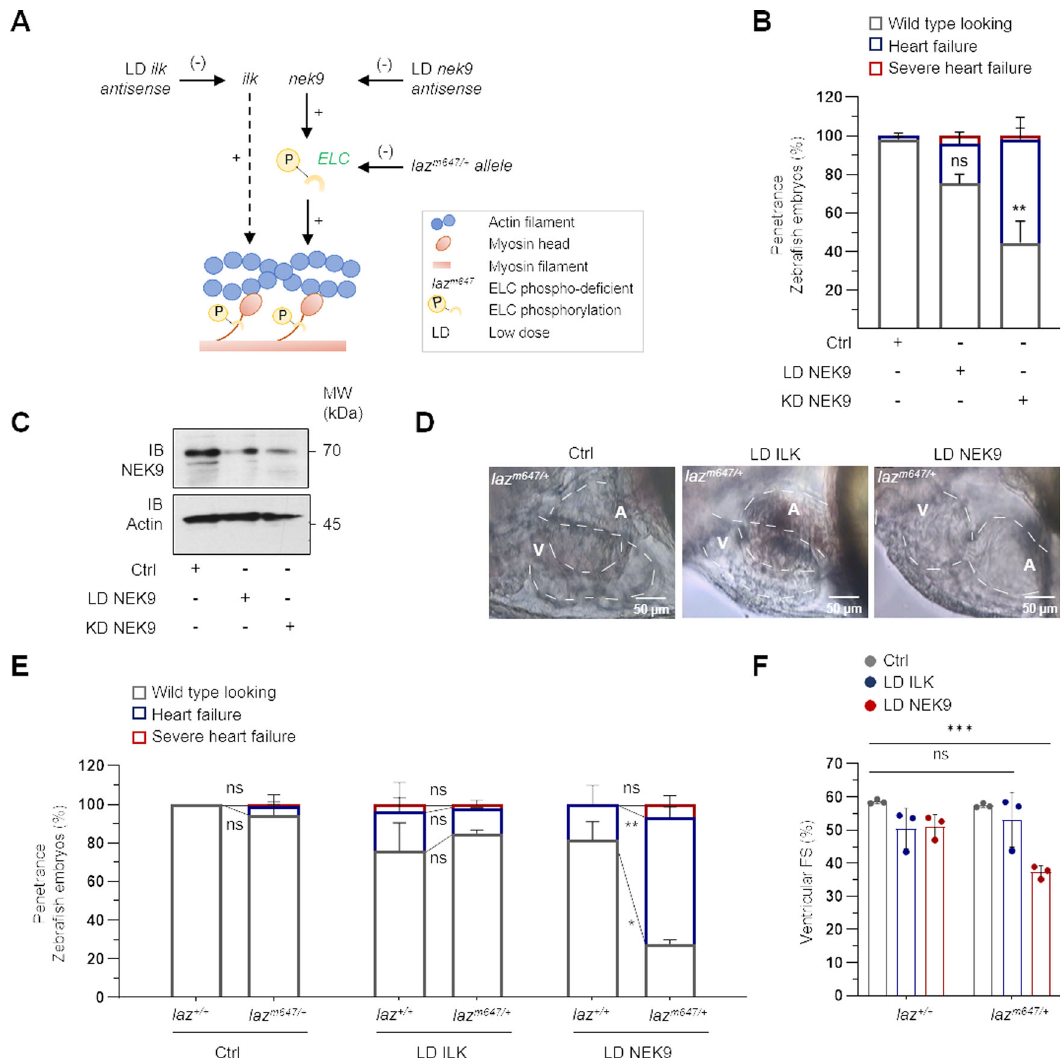
Fig.6|FunctionalcouplingofELCandNEK9in-vivo.A Schematicillustrationof geneticsensitizingby nek9 in anELC phospho-de fi cient geneticbackground.The concept is based on the progressive ampli fi cation of a response by functionally coupled factors. B Penetrance of NEK9 KD in zebra fi sh embryos at 72 hpf. Dif- ferent concentrations of antisense oligonucleotides against zebra fi sh nek9 were injected in a genetic wild-type background (KD NEK9: knockdown of NEK9 resulting in a signi fi cant heart failure phenotype; LD NEK9: low-dose knockdown showing no phenotypical effect). Data are mean±SD (Ctrl, n =517; LD NEK9, n =162; KD NEK9, n =461 fi sh embryos out of 4 (Ctrl), 3 (LD NEK9) and 5 (KD NEK9) experiments). For statistical analysis a mixed effect model followed by Bonferroni ’ s multiple comparisons test was used. ** P <0.01 shown for the